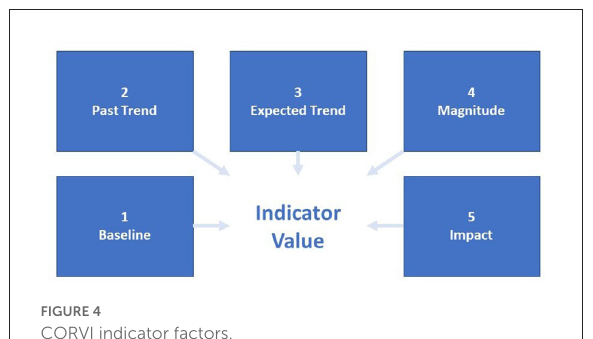
FIGURE4 CORVI indicator